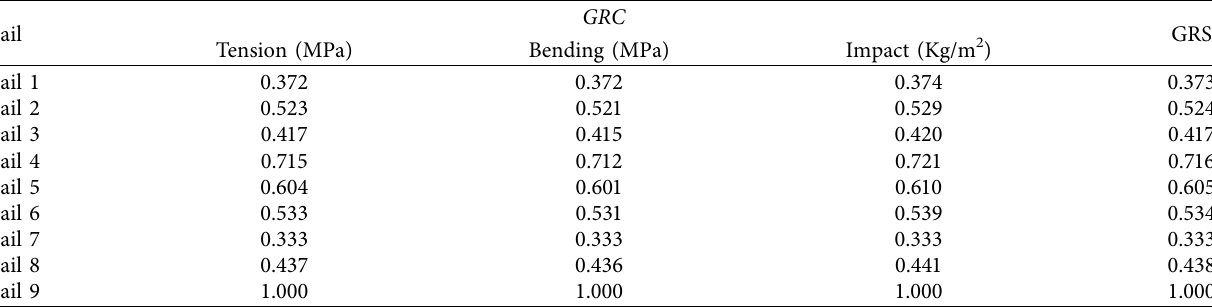
Table 5: GRC as well as GRS of a mixture.